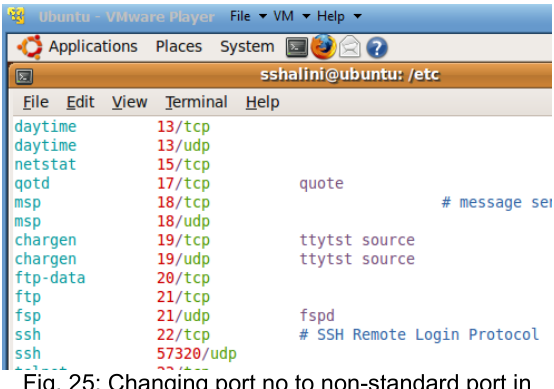
Fig. 25: Ch anging port no to non-standard port in services